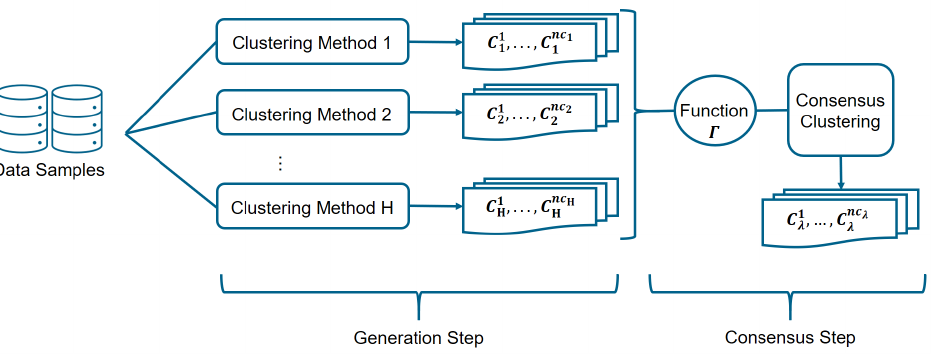
Figure 5. The clustering ensemble algorithm diagram shows the clustering aggregation